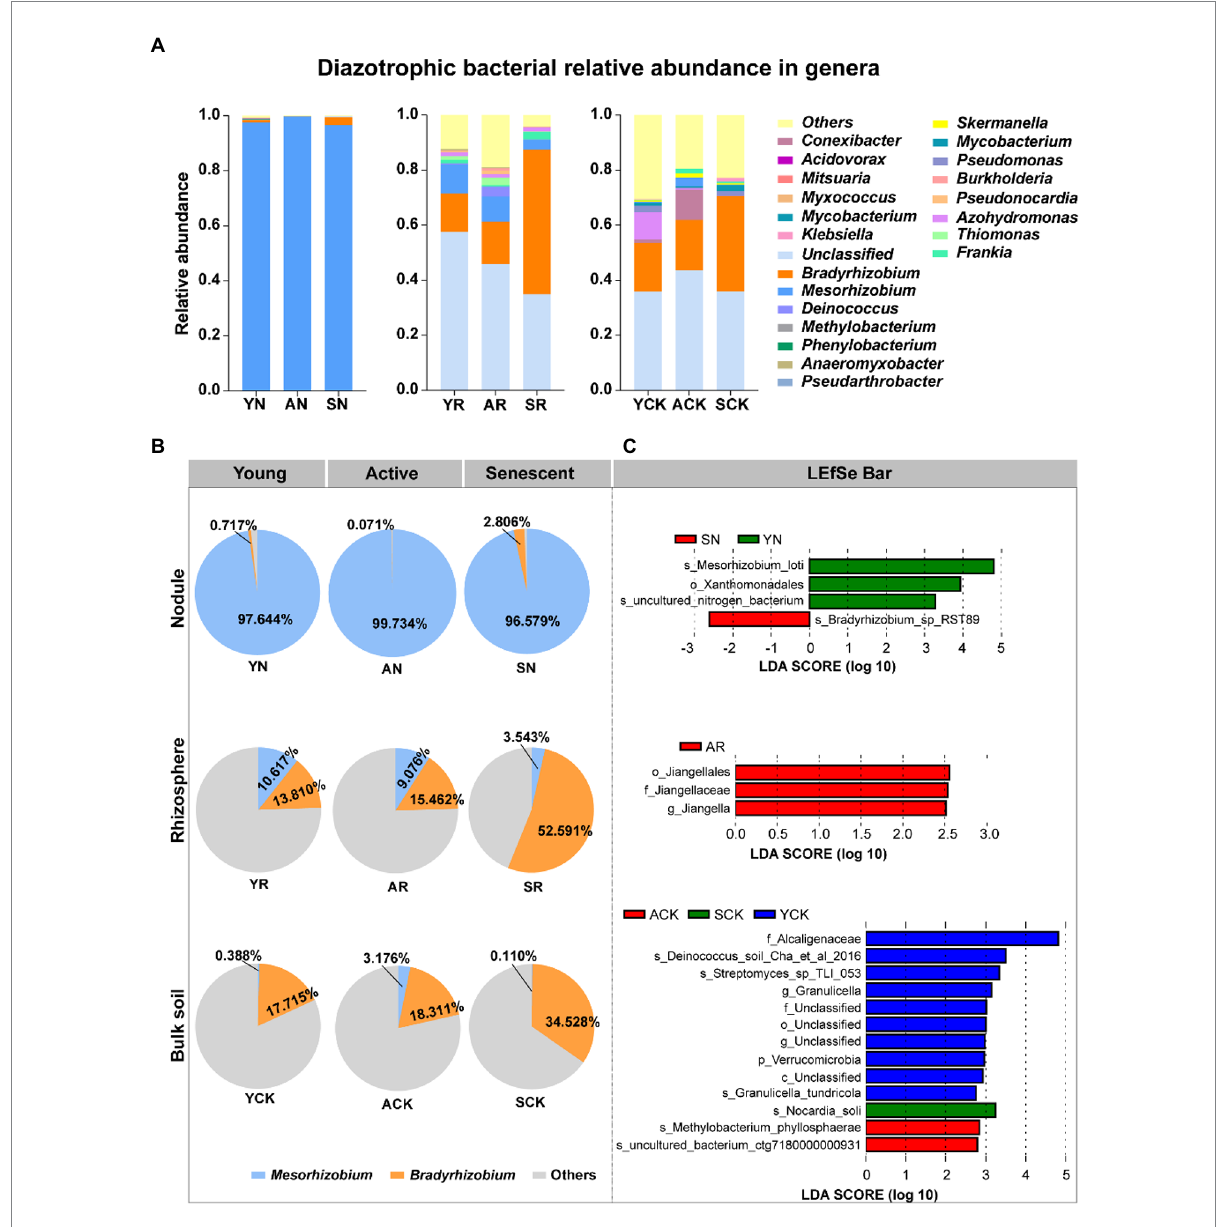
FIGURE 3 Comparison of the major bacterial composition. (A) The distribution of communities at genus level. (B) Proportion of relative abundances of Mesorhizobium and Bradyrhizobium in nine samples. (C) Differentially abundant diazotroph taxa in nodules, rhizosphere soil and bulk soil. Detected using linear discriminant analysis effect size